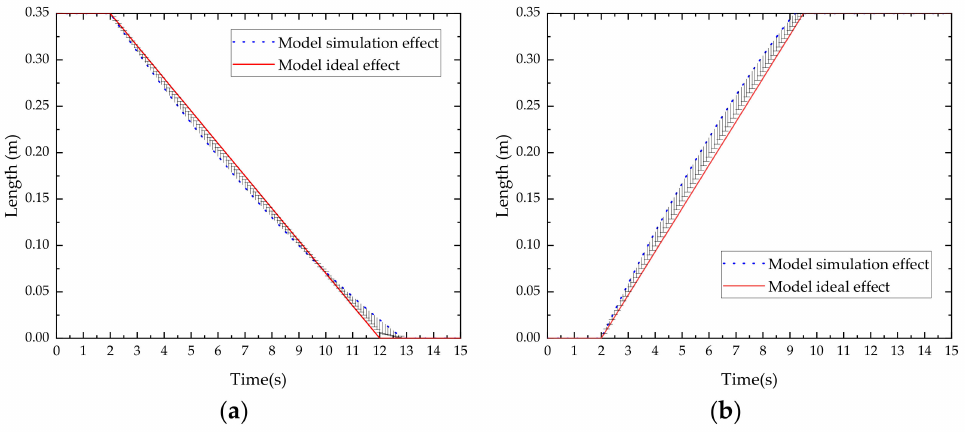
Figure 15. Simulation result of diagnostic model: ( a ) actuator retraction; ( b ) actuator